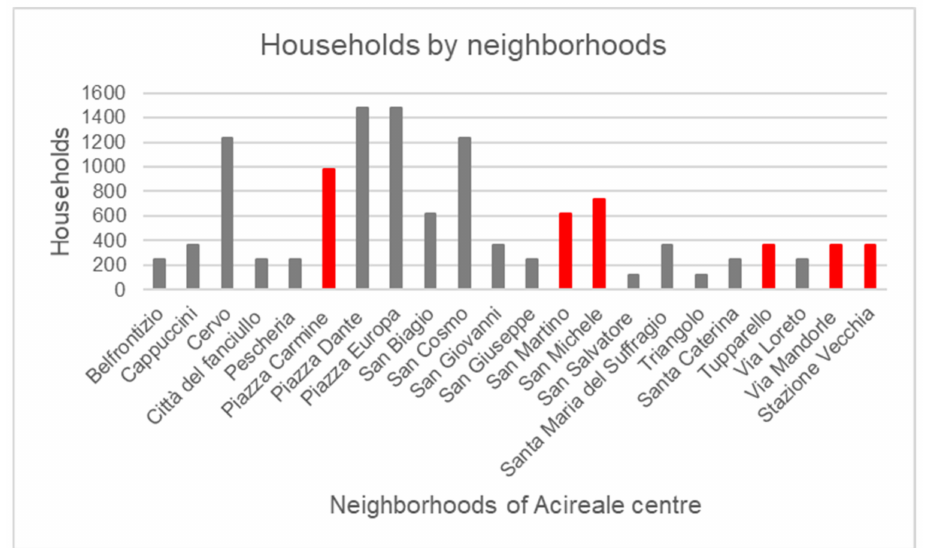
Figure 6. Distribution of households by neighbourhoods of Acireale centre (histograms in red highlight the households of the neighbourhoods directly involved in the project, those in grey the households in the other neighbourhoods of Acireale